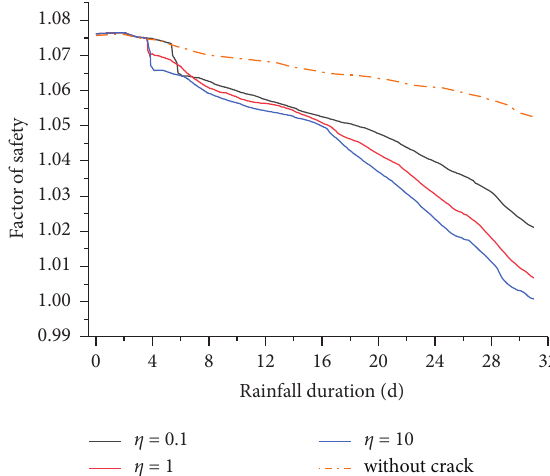
Figure 16: Factor of safety of the potential sliding surface of the slope during the